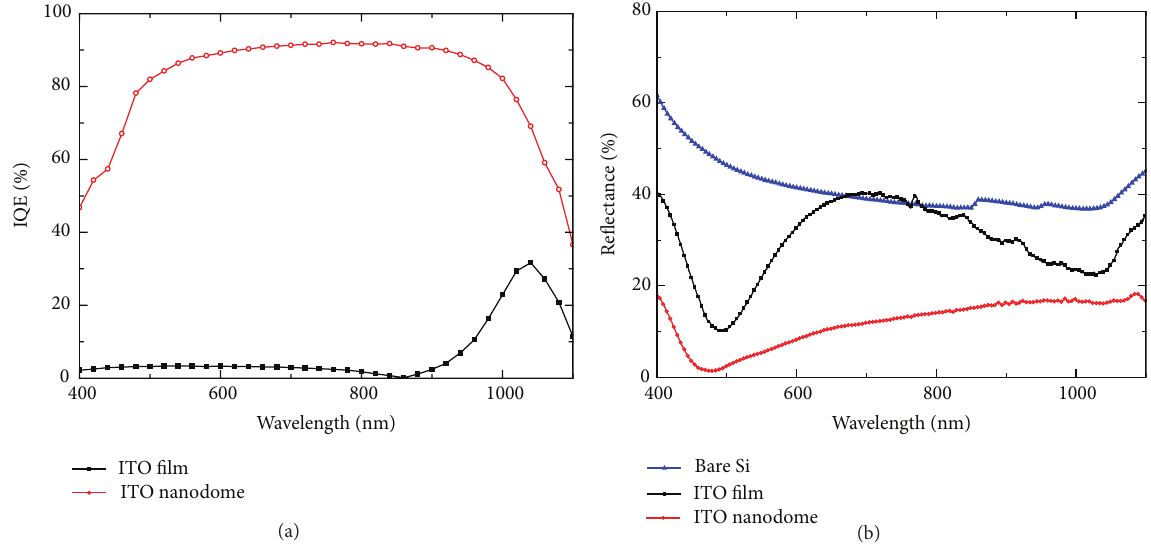
Figure 3: (a) Internal quantum efficiency and (b) reflectance profiles of planar and nanodome ITO films